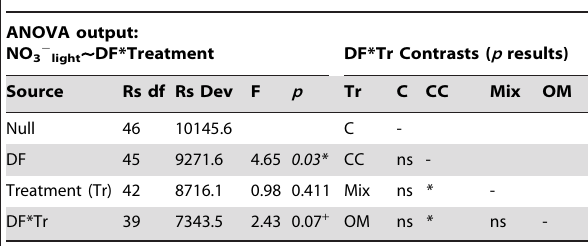
Table 5. ANOVA output from the GLM Model 4b (Gaussian distribution, identity link function) indicating the significance of NO 3 2 flux during daylight on the abundance of deposit feeders (DF) among treatments (OM: Organic matter, CC: Calcium carbonate, Mix: OM + CC, and C: Control).